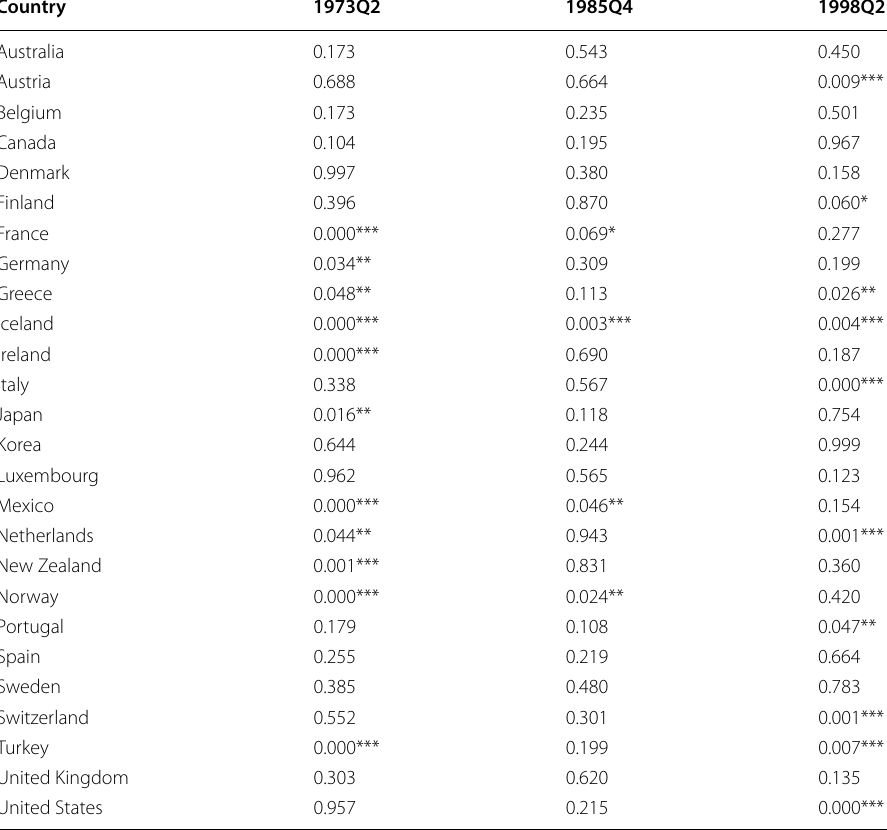
*represents statistical significance at 10 %, ** at 5 %, *** at 1